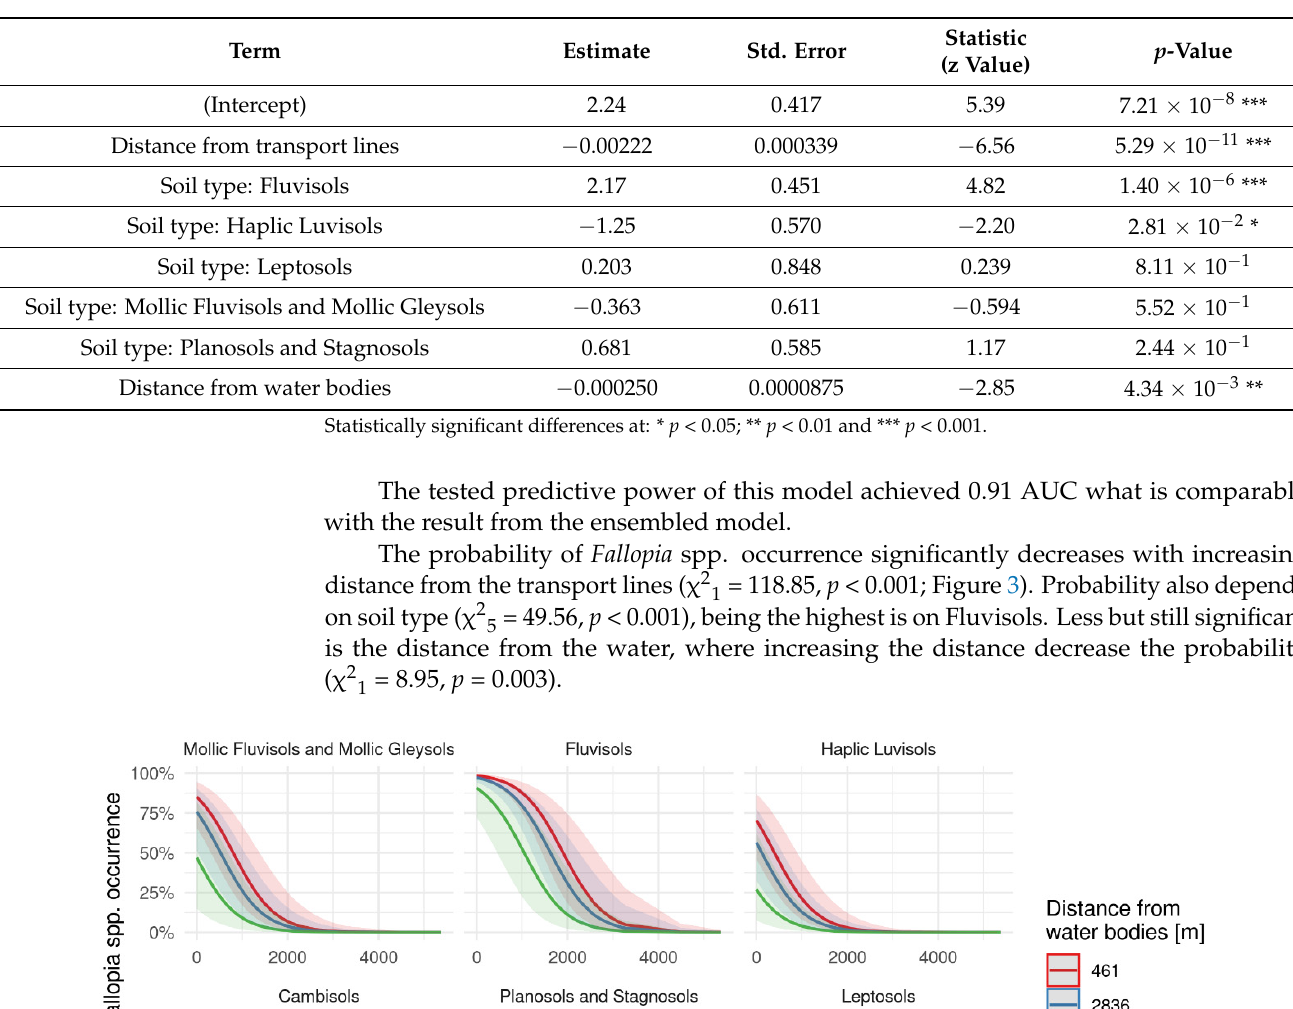
Table 2. Coefficient table of logistic regression model.